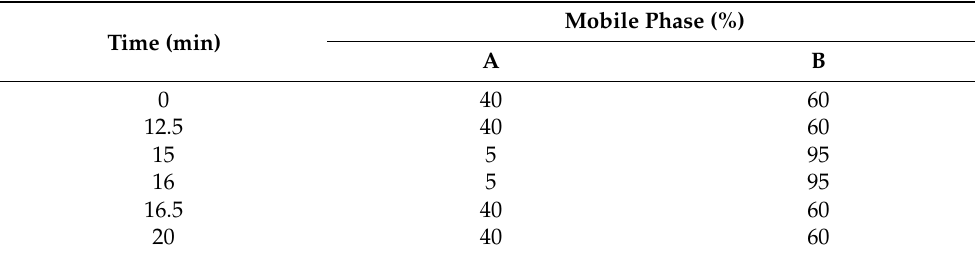
Table 2. Gradient used for the liquid chromatography mobile